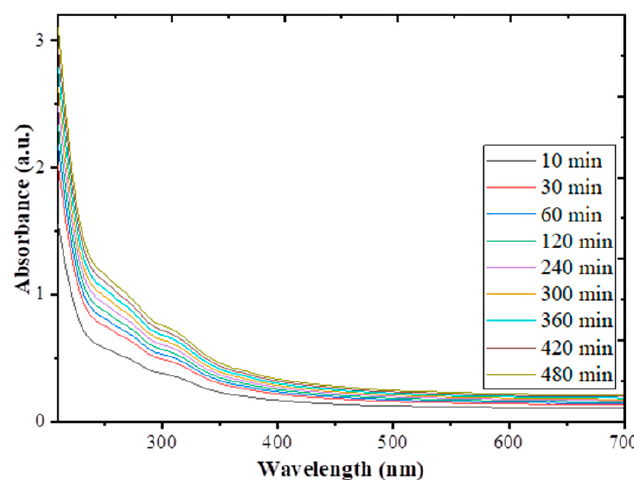
Figure 1. Time-dependent UV-vis spectra for green synthesized ZnO@XG